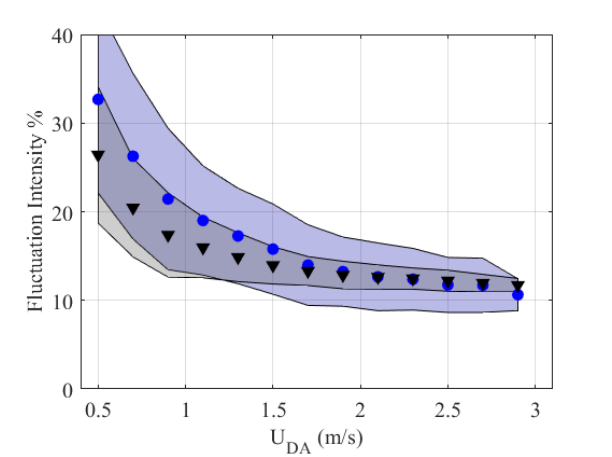
Fig. 3. Variation of fluctuation intensity at the hub height for each turbine position, Top turbine position (blue markers), Bottom turbine position (black markers).The shaded region represents the range of the intensity values at each U DA .